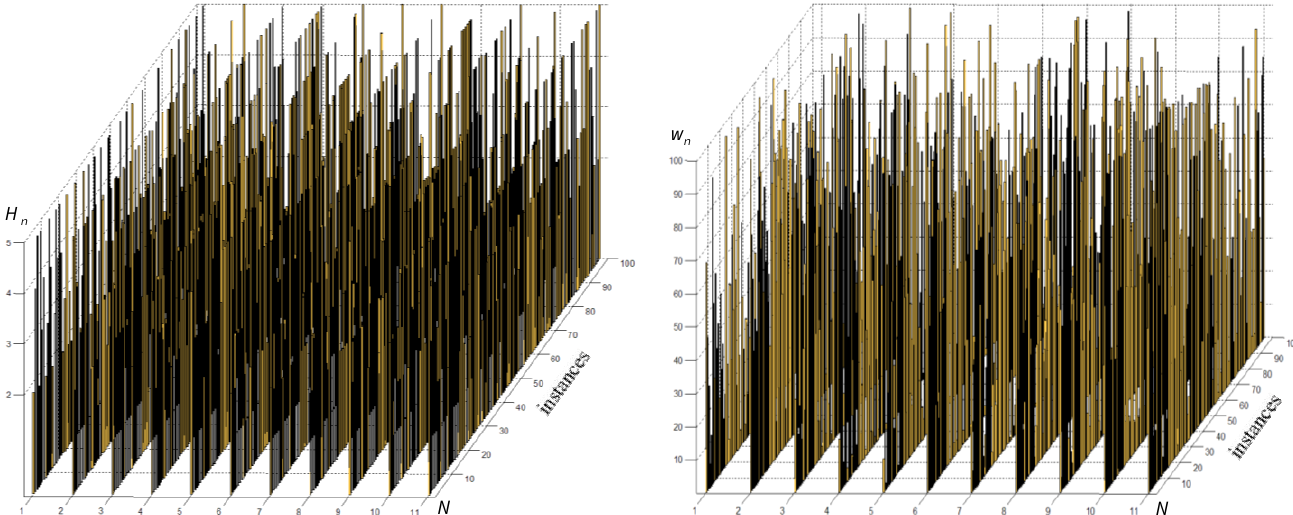
Fig. 9. Job lengths and weights generated for 100 instances of scheduling 11 jobs, where 67 instances are unique. The 53 non-timeout instances are barred with a lighter colour. The 39 non-timeout instances are unique. Such a violation of the pseudorandomness is a consequence of parallelising generations (53) and (54).